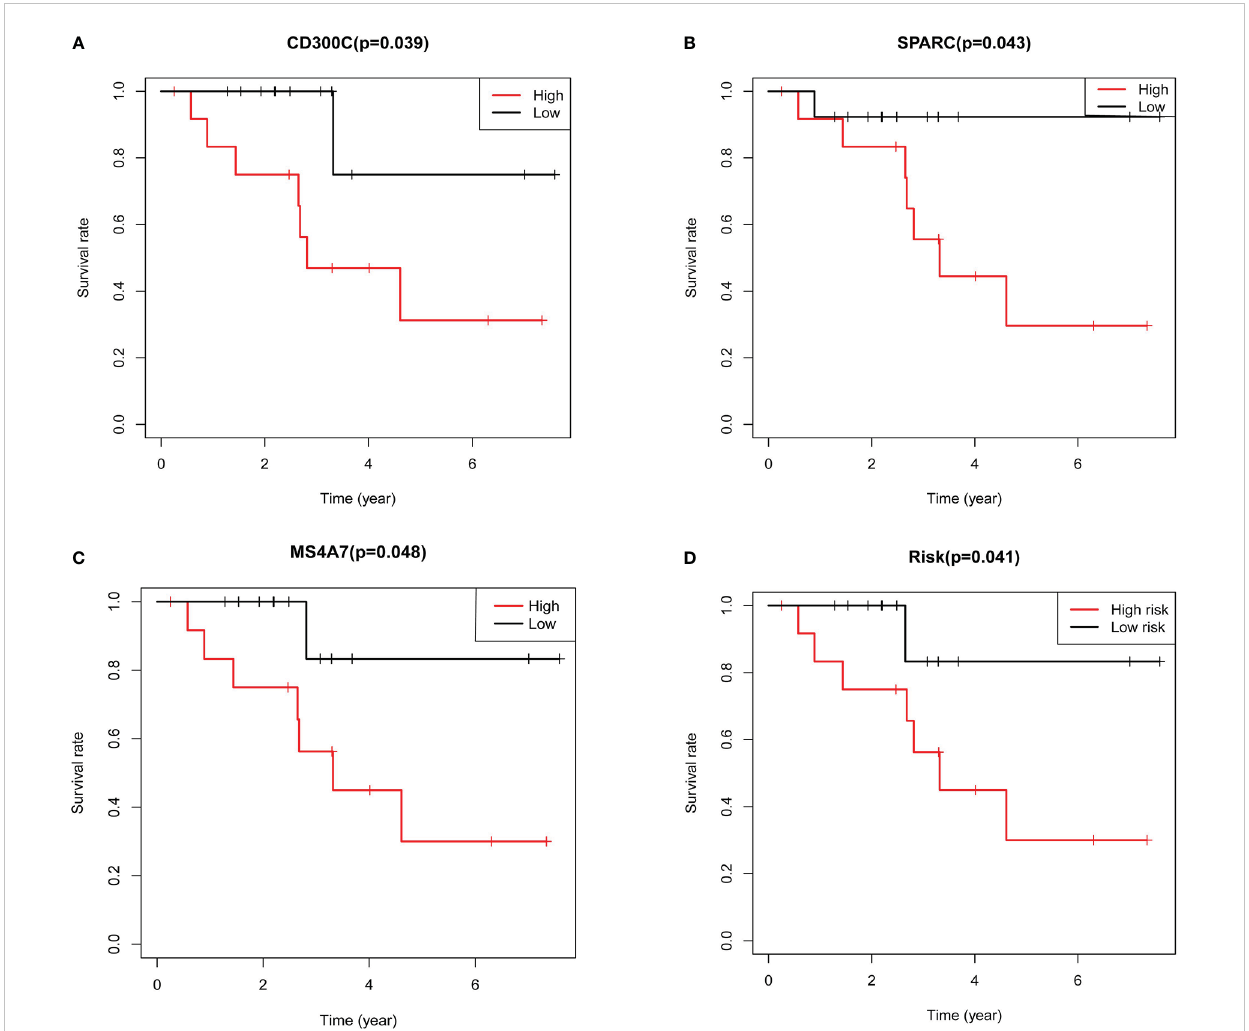
FIGURE 5 Results of further validation based on qRT-PCR: A shows the results of survival analysis based on expression of CD300C, B shows the results of survival analysis based on expression of SPARC, C shows the results of survival analysis based on expression of MS4A7, D shows the results of survival analysis based on the risk